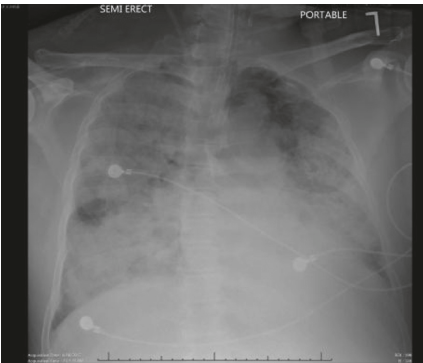
Figure 1: Chest X-ray showing diffuse bilateral alveolar